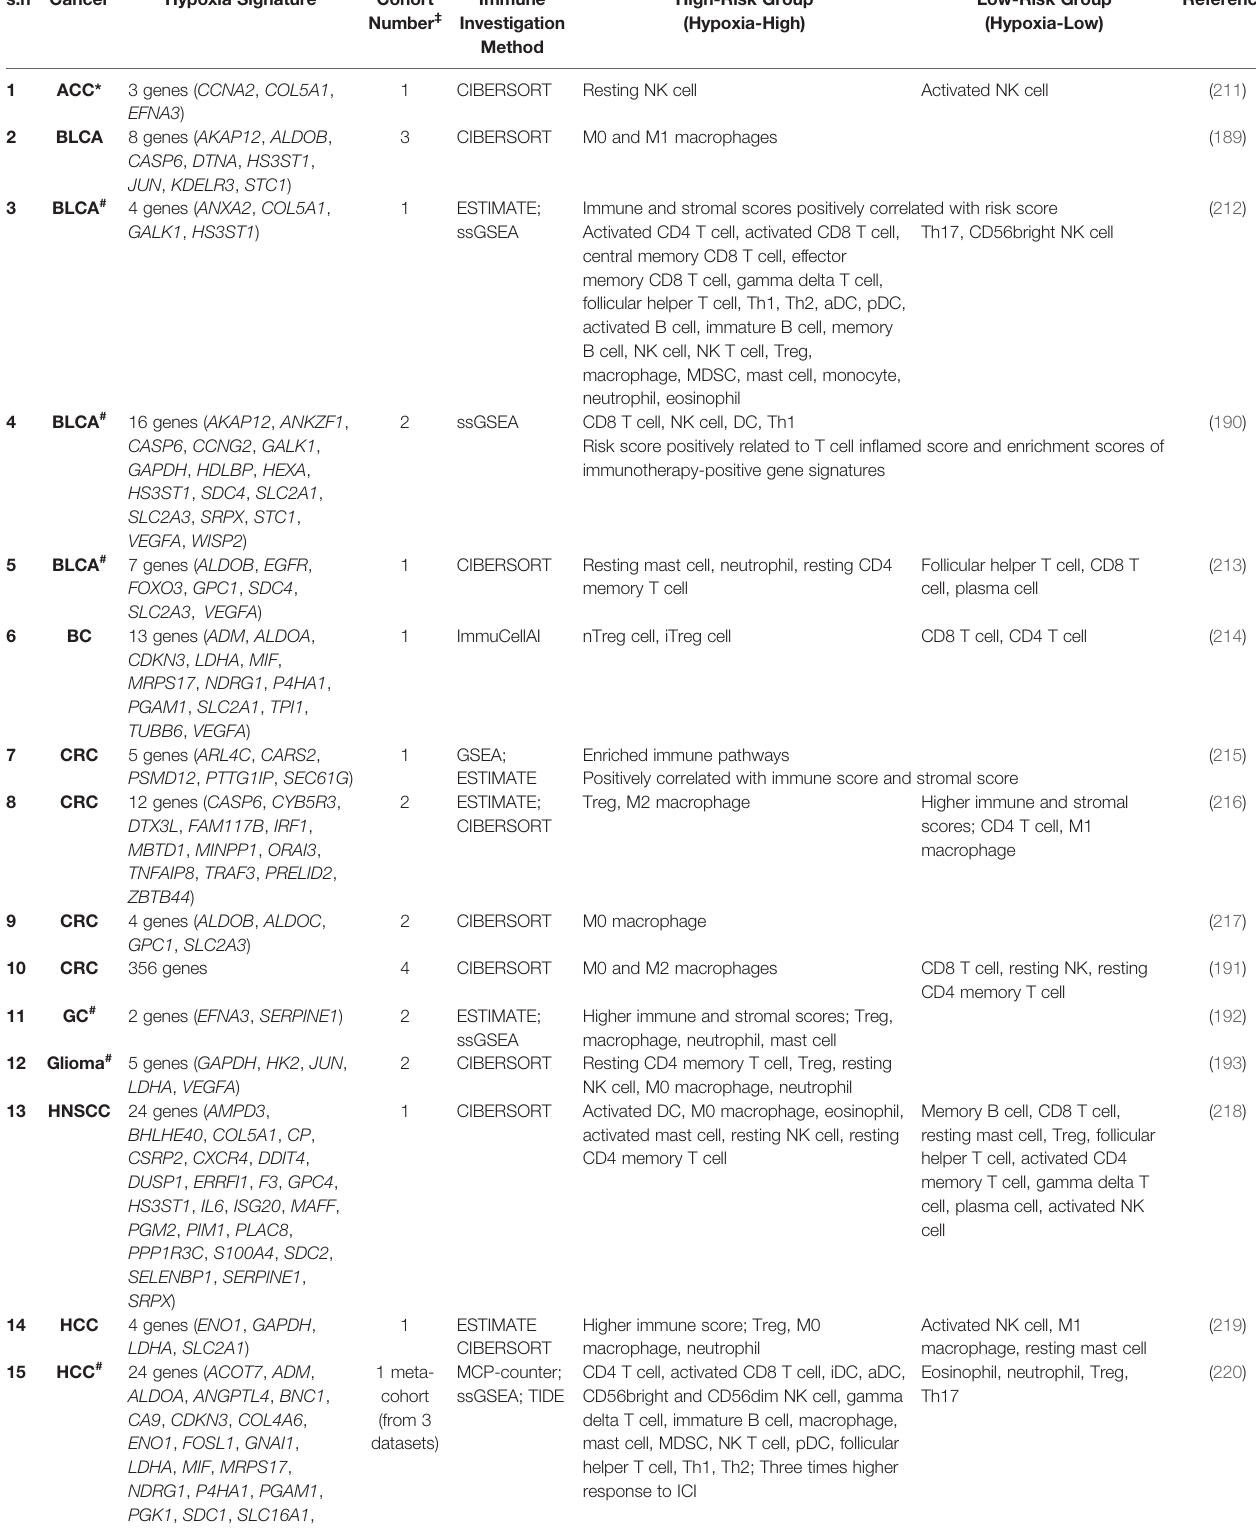
TABLE 1 | Studies applying computational tools to investigate the immune landscape of tumors classi fi ed based on hypoxia signatures. s.n